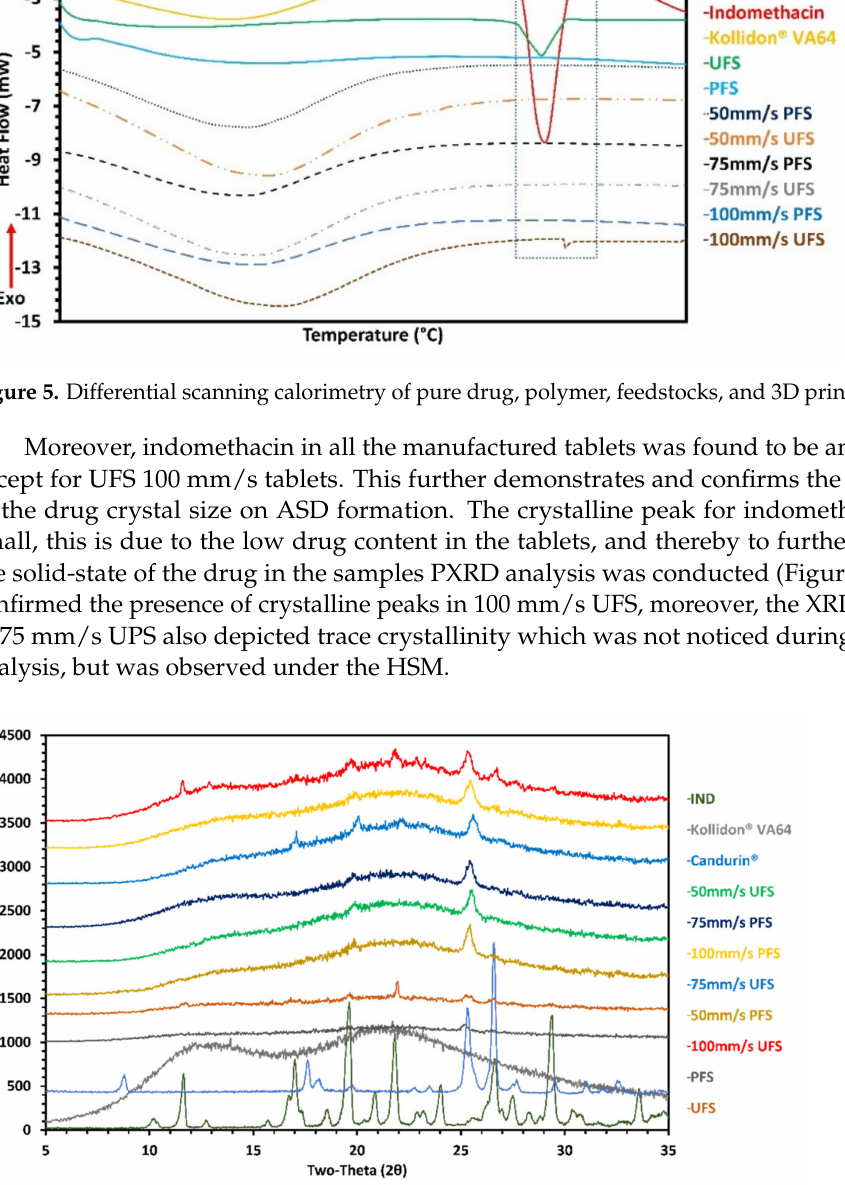
Figure 6. X-ray diffraction of pure drug, polymer, feedstocks, and 3D printed